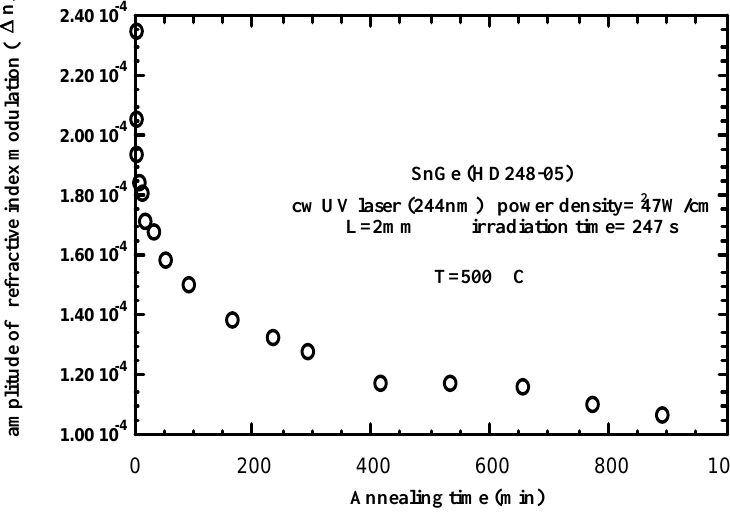
Figure 31. Isotherms from Razafimahatratra, reprinted with permission from [37]. Copyright 2000 University Lille